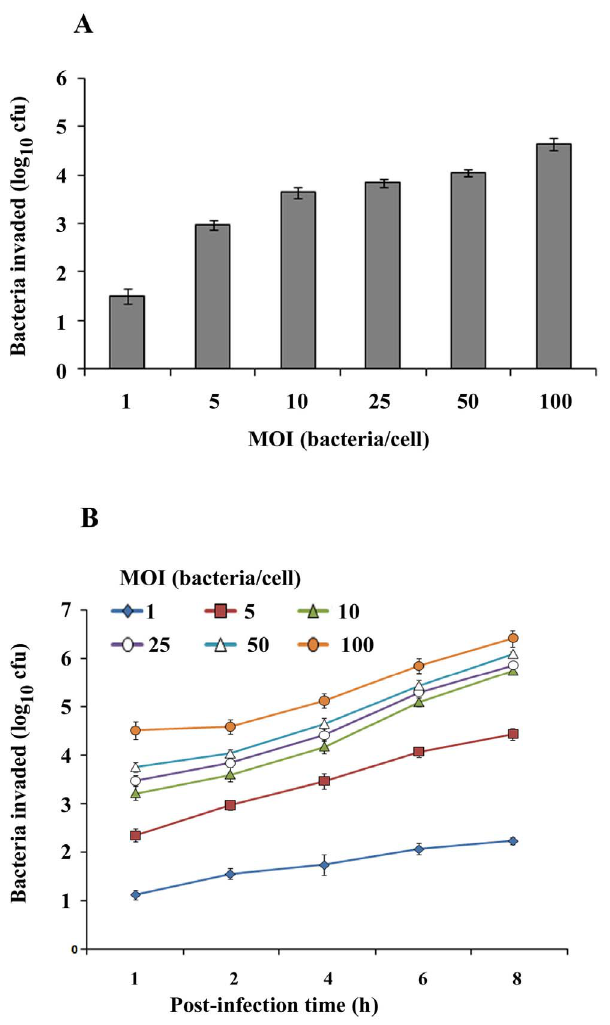
Figure 1. Invasion of P.aeruginosa in HMEECs is dose and time dependent. HMEECs were infected with at different MOI for 2h and invasion was determined by gentamicin protection assay (A). In separate experiments, HMEECs were infected with P. aeruginosa at an MOI of 10 for varying time periods and bacterial invasion was determined by gentamicin protection assay (B). Data represents mean 6 SD. Results are representative of five independent experiments carried out in triplicate.